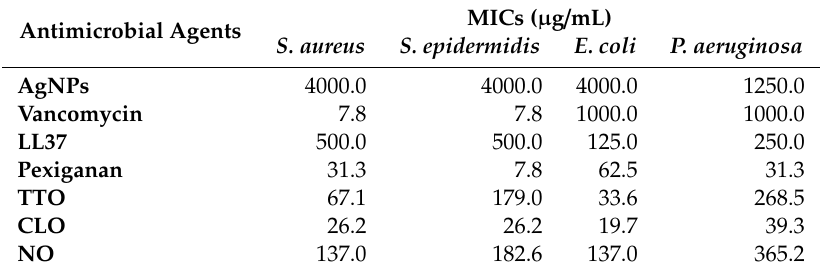
Table 2. Minimal inhibitory concentrations (MICs) of selected antimicrobial agents against Gram-positive and Gram-negative bacteria ( n = 3, SD < ± 5.0). Antimicrobial